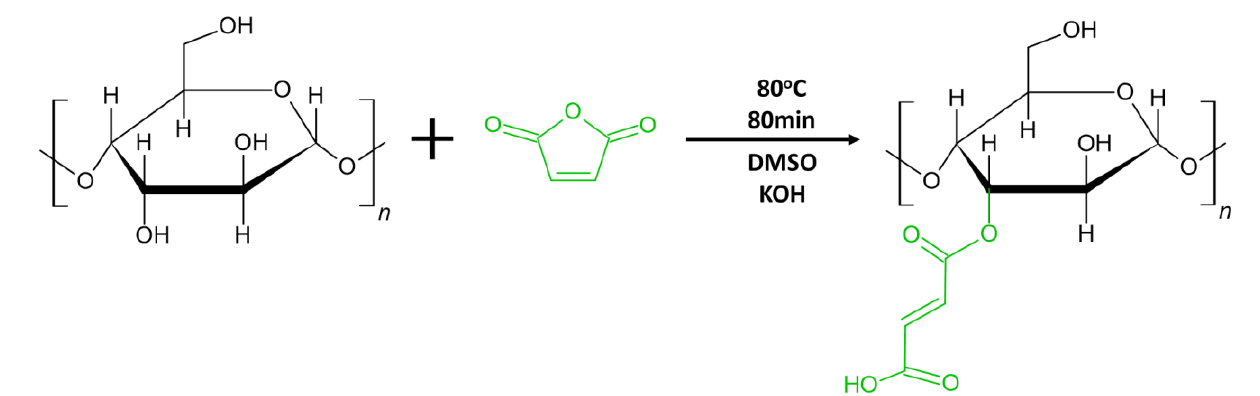
Figure 2. Chemical schematic for maleinization of beechwood hemicellulose xylan.